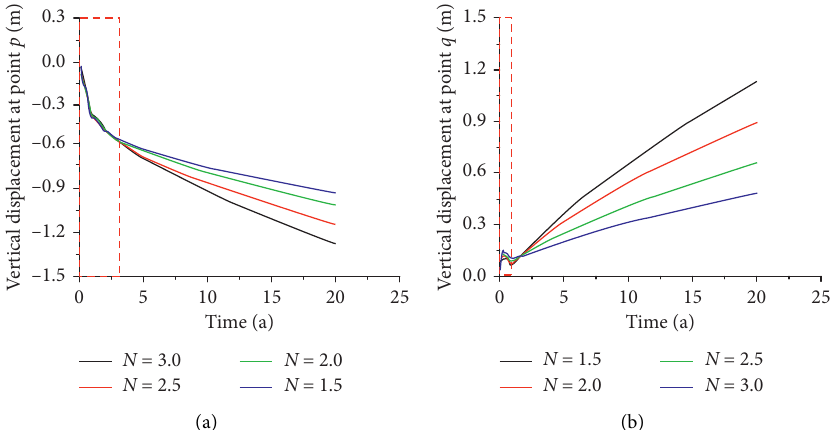
Figure 6: Vertical displacement changes at points p and q of a single-cavern horizontal salt rock underground storage. (a) Point p . (b) Point q .